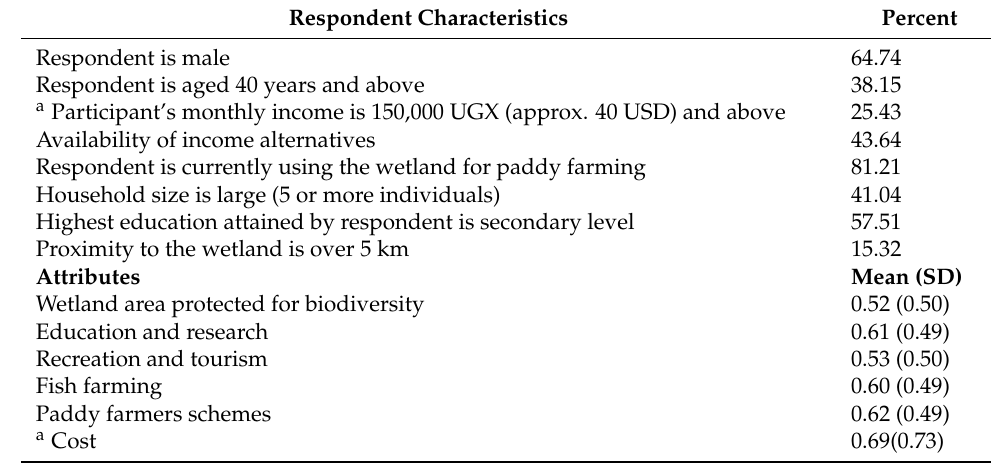
Table 3. Descriptive statistics of the variables used for analysis of attribute